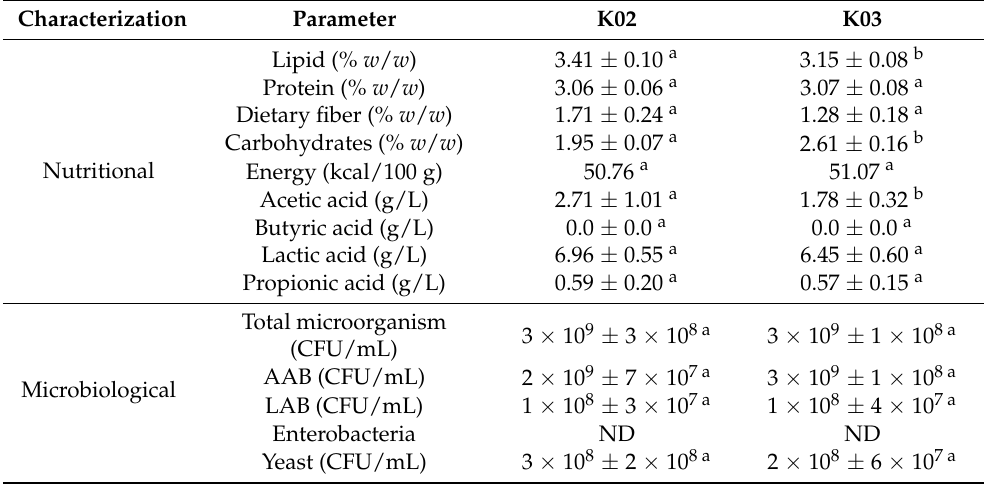
Table 1. Nutritional and microbiological properties of kefir